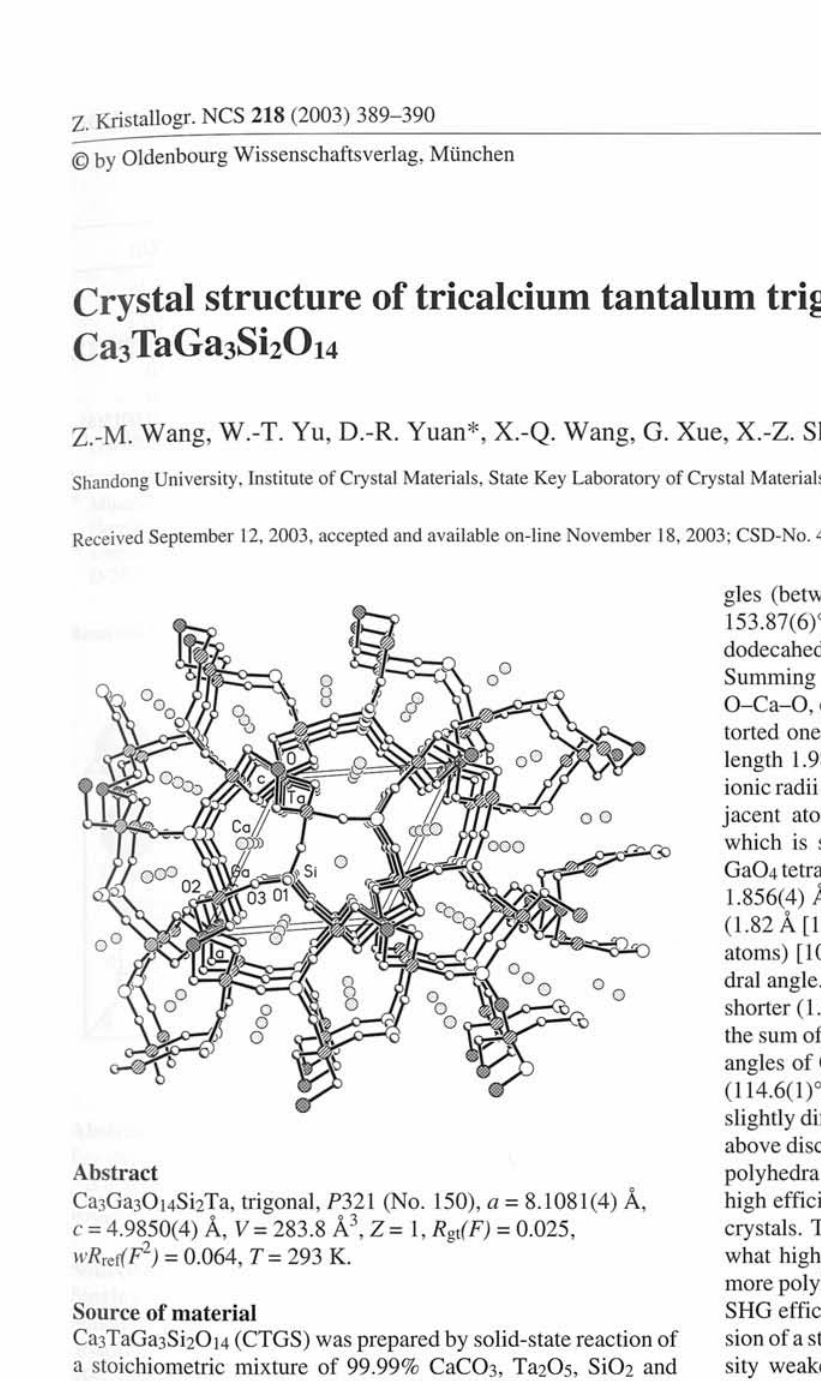
Table X. Data collection and handling.